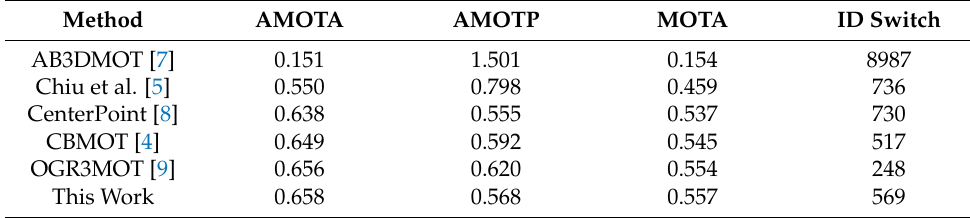
Table 9. Comparison on the nuScenes test